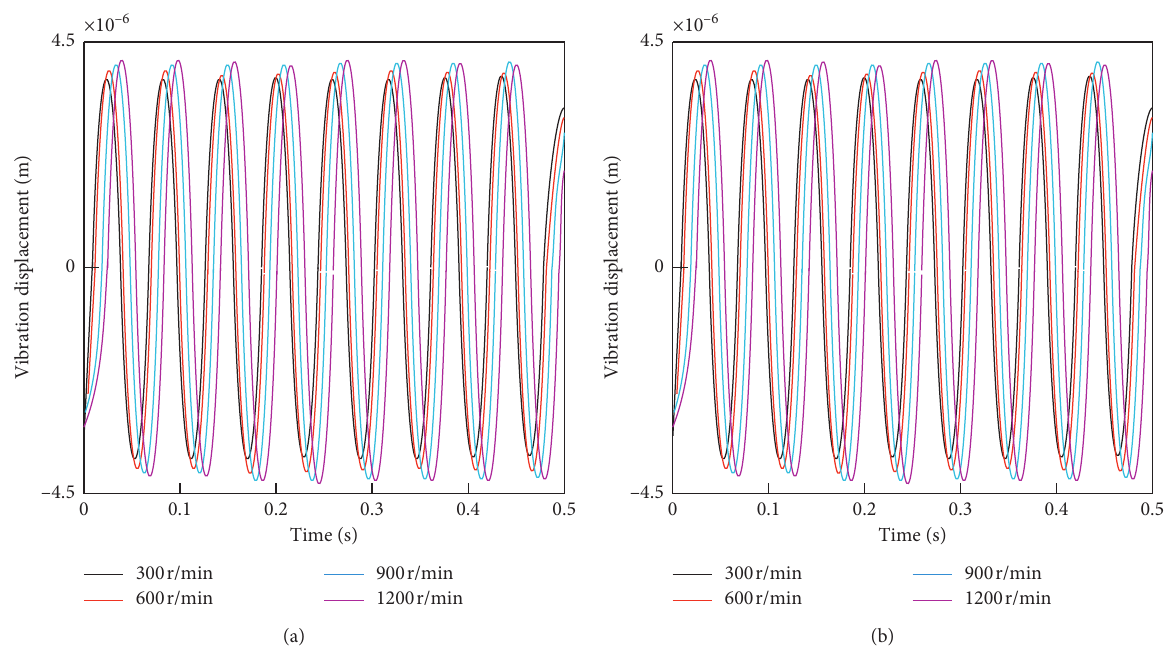
Figure 4: Radial vibration displacement at different speeds. (a) Vibration displacement of radial x . (b) Vibration displacement of radial y .